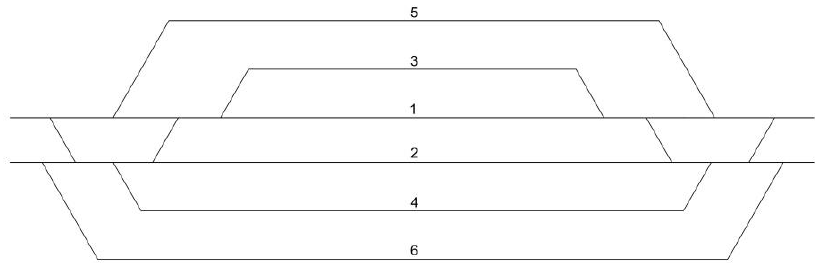
Figure 6. A better alternative track layout diagram for a small overtaking station on a double-track